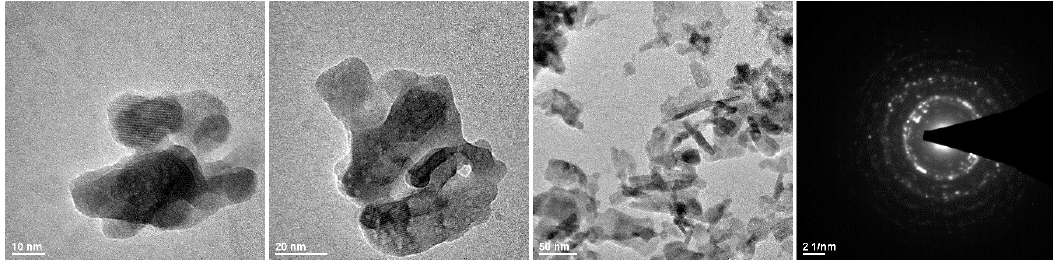
Figure 1 . Representative TEM images and a SAED image of the 3 mol% Eu 3+ :Ca 10 (PO 4 ) 6 (OH) 2 . Figure 1. Representative TEM images and a SAED image of the 3 mol% Eu 3 + :Ca